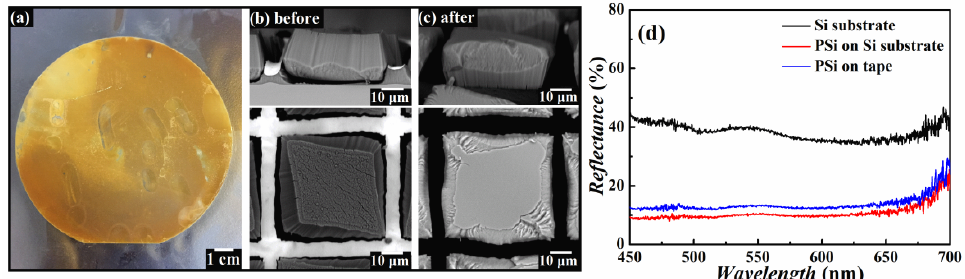
Figure 3. ( a ) Optical image of a large area (4”) transferred PSi films onto flexible tape. SEM images (top: cross-sectional view, bottom: top view) of PSi films ( b ) before and ( c ) after transfer. ( d ) Reflectance spectra of PSi films before and after transfer onto tape.